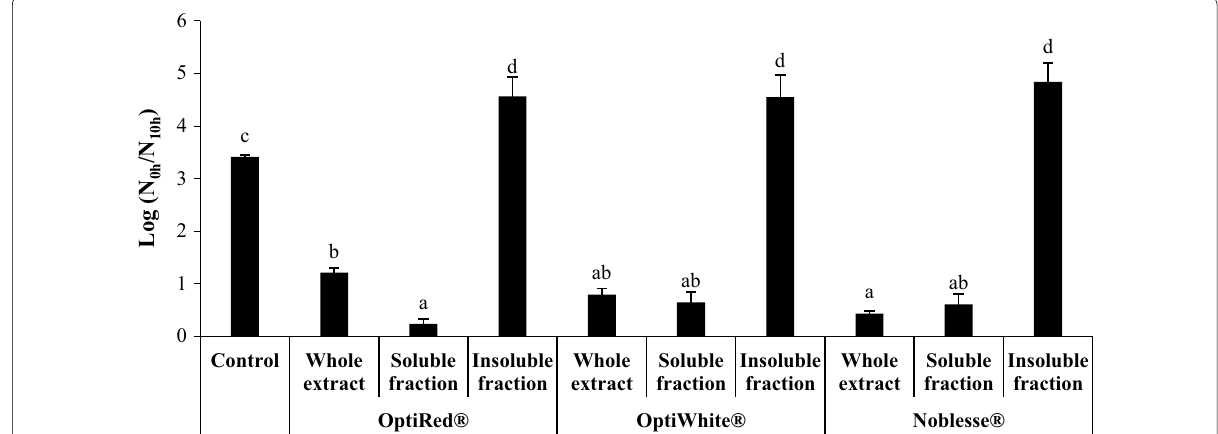
Fig. 2 Effect of water-soluble and insoluble fractions of IYDs on the viability of L. rhamnosus HN001. Different lowercase letters indicate significant differences ( P < 0.05). Values are the mean of triplicate experiments ( n 3), with error bars representing the standard deviations of the mean values =